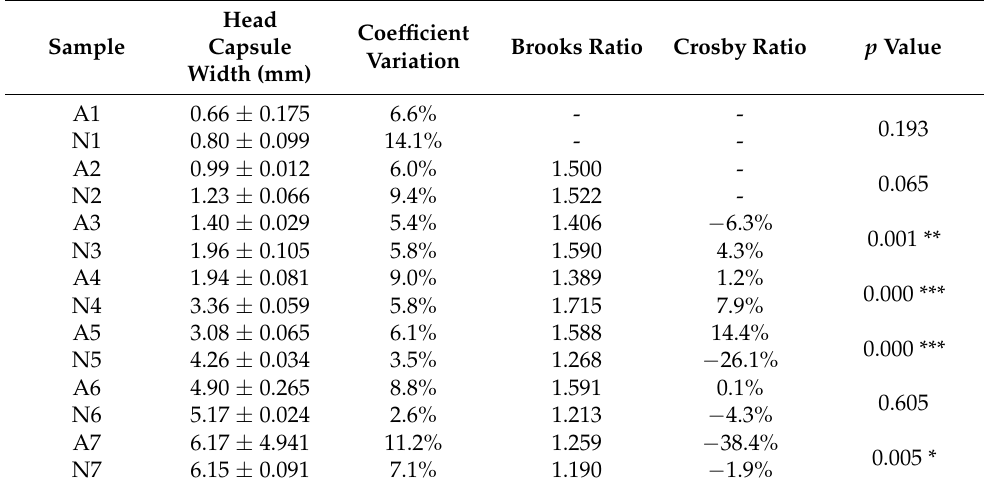
Table 1. The head capsule widths of L. xylina larvae fed on SAC and NAC